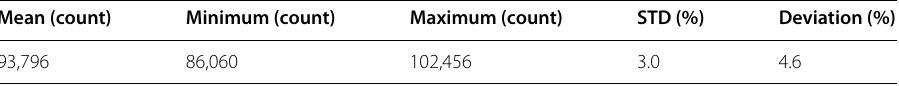
Table 6 Uniformity measurement for the uniform region of the NEMA image quality phantom Mean (count)